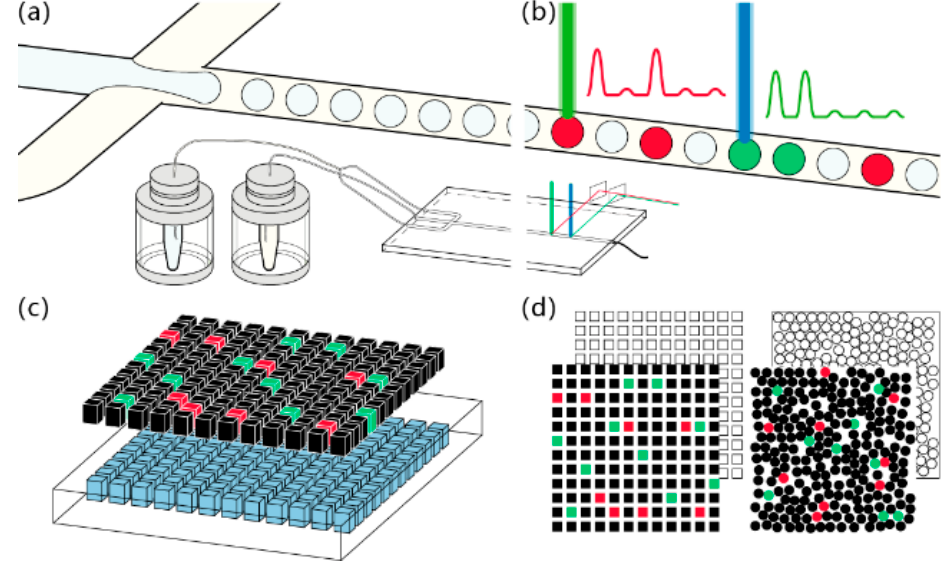
Figure 2. Microfluidic digital PCR partitioning and counting strategies. ( a ) Emulsion droplet generation using flow-focusing microfluidic chip; ( b ) Serial droplet fluorescence reading; ( c ) Minute volumes of PCR sample are partitioned in micro-well microfluidic chip; ( d ) Planar imaging for fluorescence positive chamber counting.